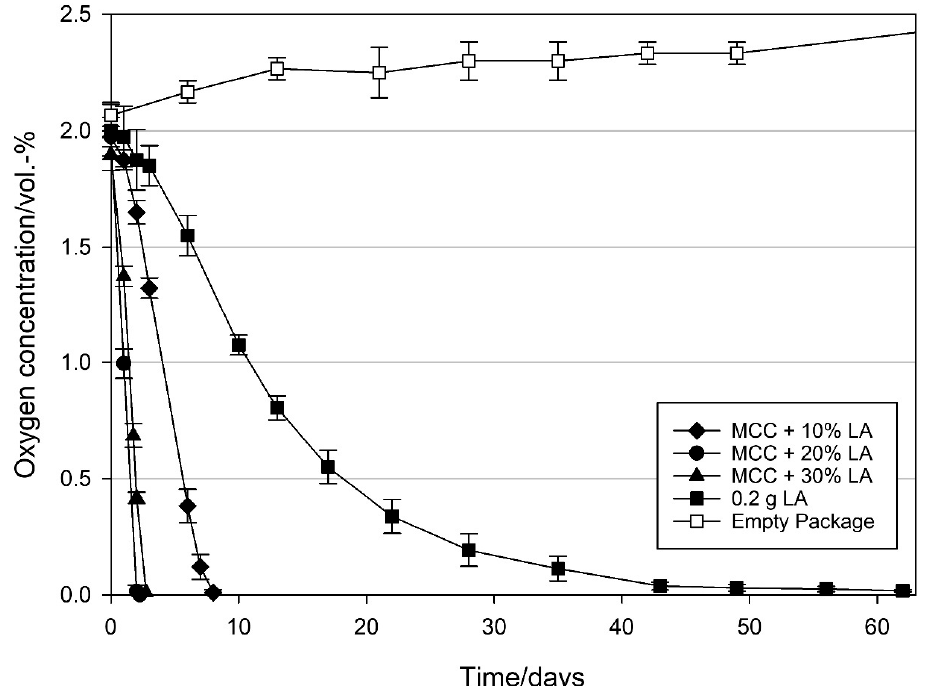
Figure 4. Oxygen concentration in packages containing 1 g modified calcium carbonate (MCC) loaded with 10, 20, and 30 wt% linoleic acid, 0.2 g pure linoleic acid and empty package. Packed under modified atmosphere (MAP, 2 vol.-% O 2 , rest N 2 ; headspace 250 mL) and stored at 21 °C. Mean values and standard deviation (n = 4).